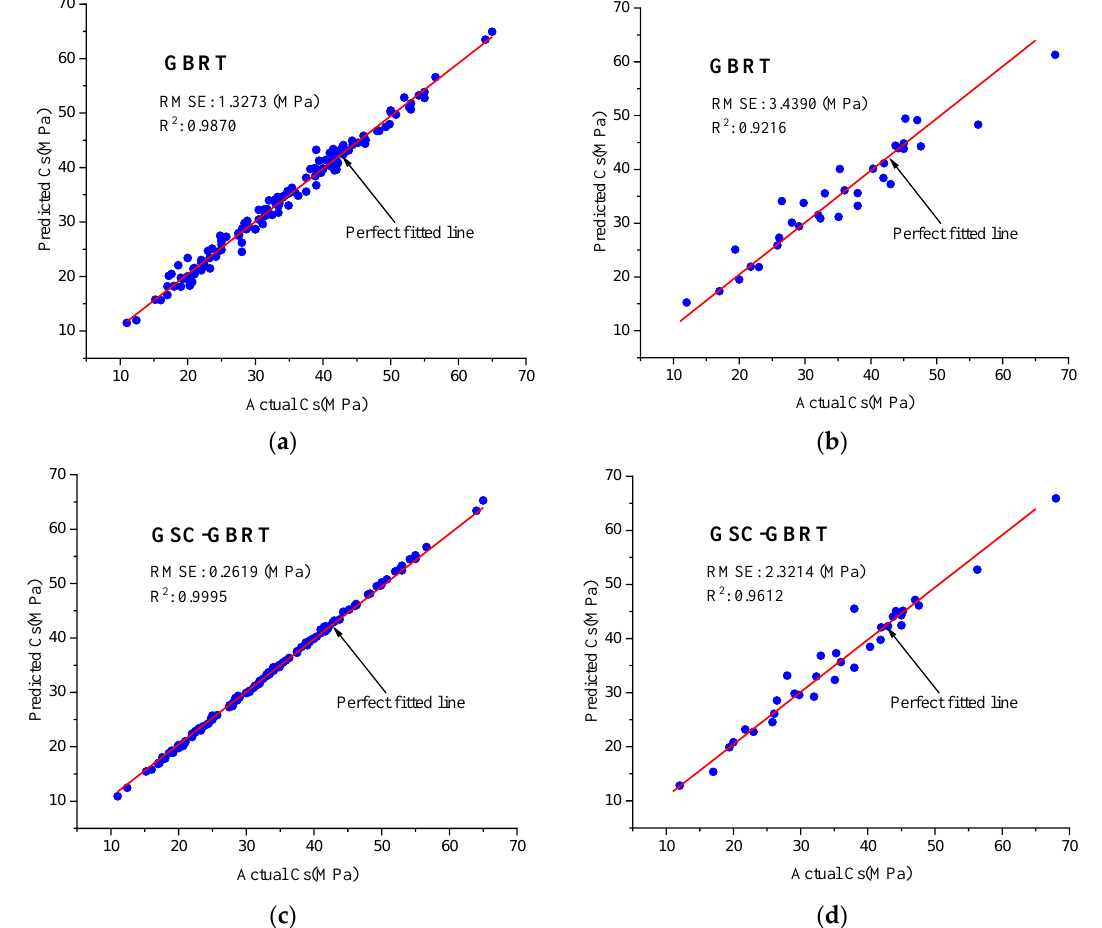
Figure 5. Results of the GSC-GBRT and GBRT models for the testing and training datasets. ( a ) GBRT training set. ( b ) GBRT testing set. ( c ) GSC-GBRT training set. ( d ) GSC-GBRT testing set.